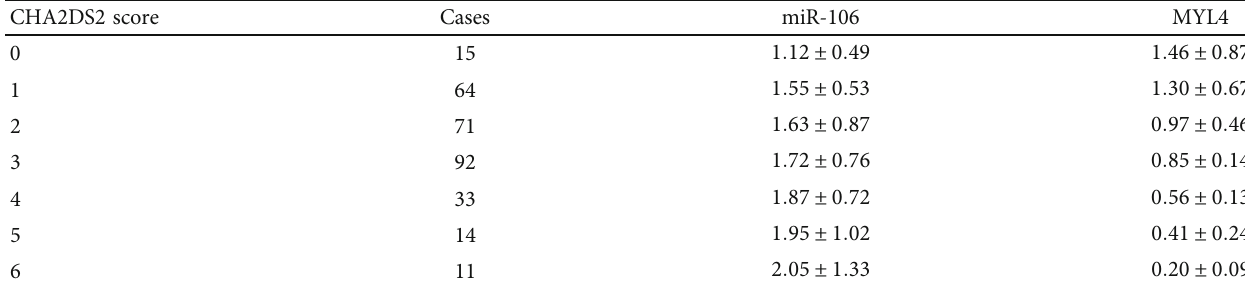
Table 6: Relationship between serum miR-106 and MYL4 levels and risk strati fi cation of AF ( (cid:1) x ± s ). CHA2DS2 score